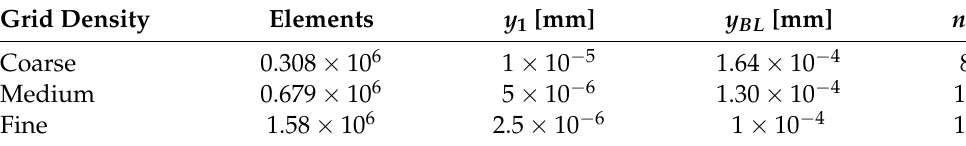
Figure 6. Detail of the surface mesh near the front chamber. Table 2. Characteristics of grids.